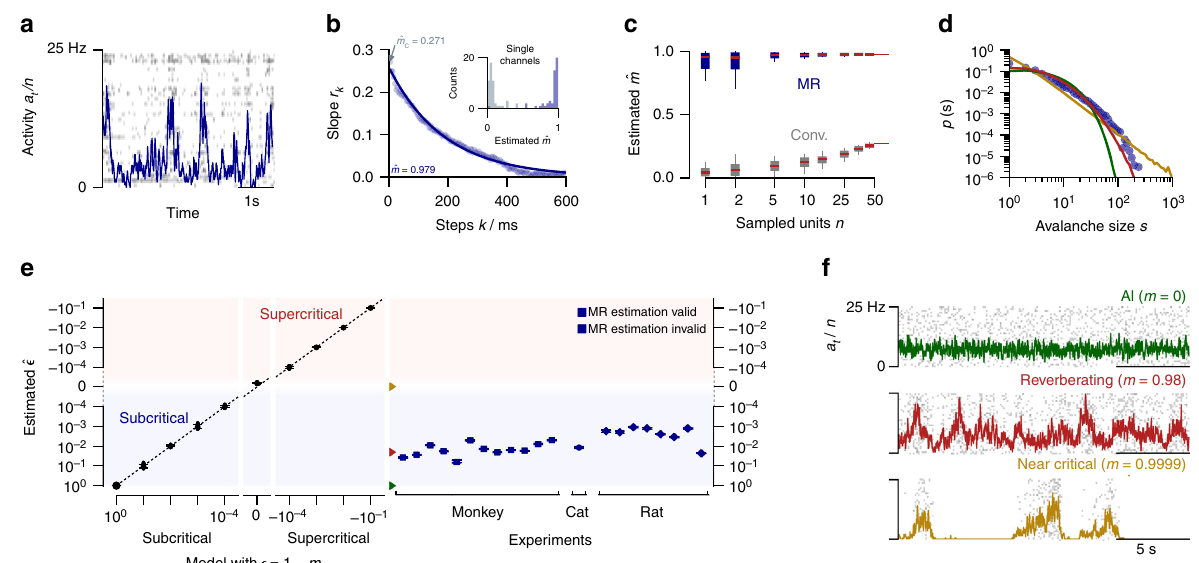
Fig. 3 Animal spiking activity in vivo. In neuroscience, m denotes the mean number of spikes triggered by one spike. We estimated ^ m from spiking activity recorded in vivo in monkey prefrontal cortex, cat visual cortex, and rat hippocampus. a Raster spike plot and population rate a t of 50 single units illustrated for cat visual cortex. b MR estimation based on the exponential decay of the autocorrelation r k of a t . Inset: Comparison of conventional and MR estimation = 0.057 and ^ m = 0.954, respectively). c ^ m estimated from further subsampled cat recordings, estimated with the results for single units (medians ^ m C conventional and MR estimator. Error bars indicate variability over 50 randomly subsampled n out of the recorded 50 channels. d Avalanche size distributions for cat visual cortex (blue) and the networks with AI, reverberating and near-critical dynamics in f . e For all simulations, MR estimation returned the correct distance to instability (criticality) ϵ = 1 − m (Supplementary Note 8). In vivo spike recordings from rat, cat, and monkey, clearly differed from critical ( ϵ = 0) and AI ( ϵ = 1) states (median ^ m = 0.98, error bars: 16 to 84% con fi dence intervals, note that some con fi dence intervals are too small to be resolved). Opaque symbols indicate that MR estimation was rejected (Supplementary Fig. 5, Supplementary Note 5). Green, red, and yellow arrows indicate ϵ for the dynamic states shown in f . f Population activity and raster plots for AI activity, reverberating, and near critical networks. All three networks match the recording from cat visual cortex with respect to number of recorded neurons and mean fi ring